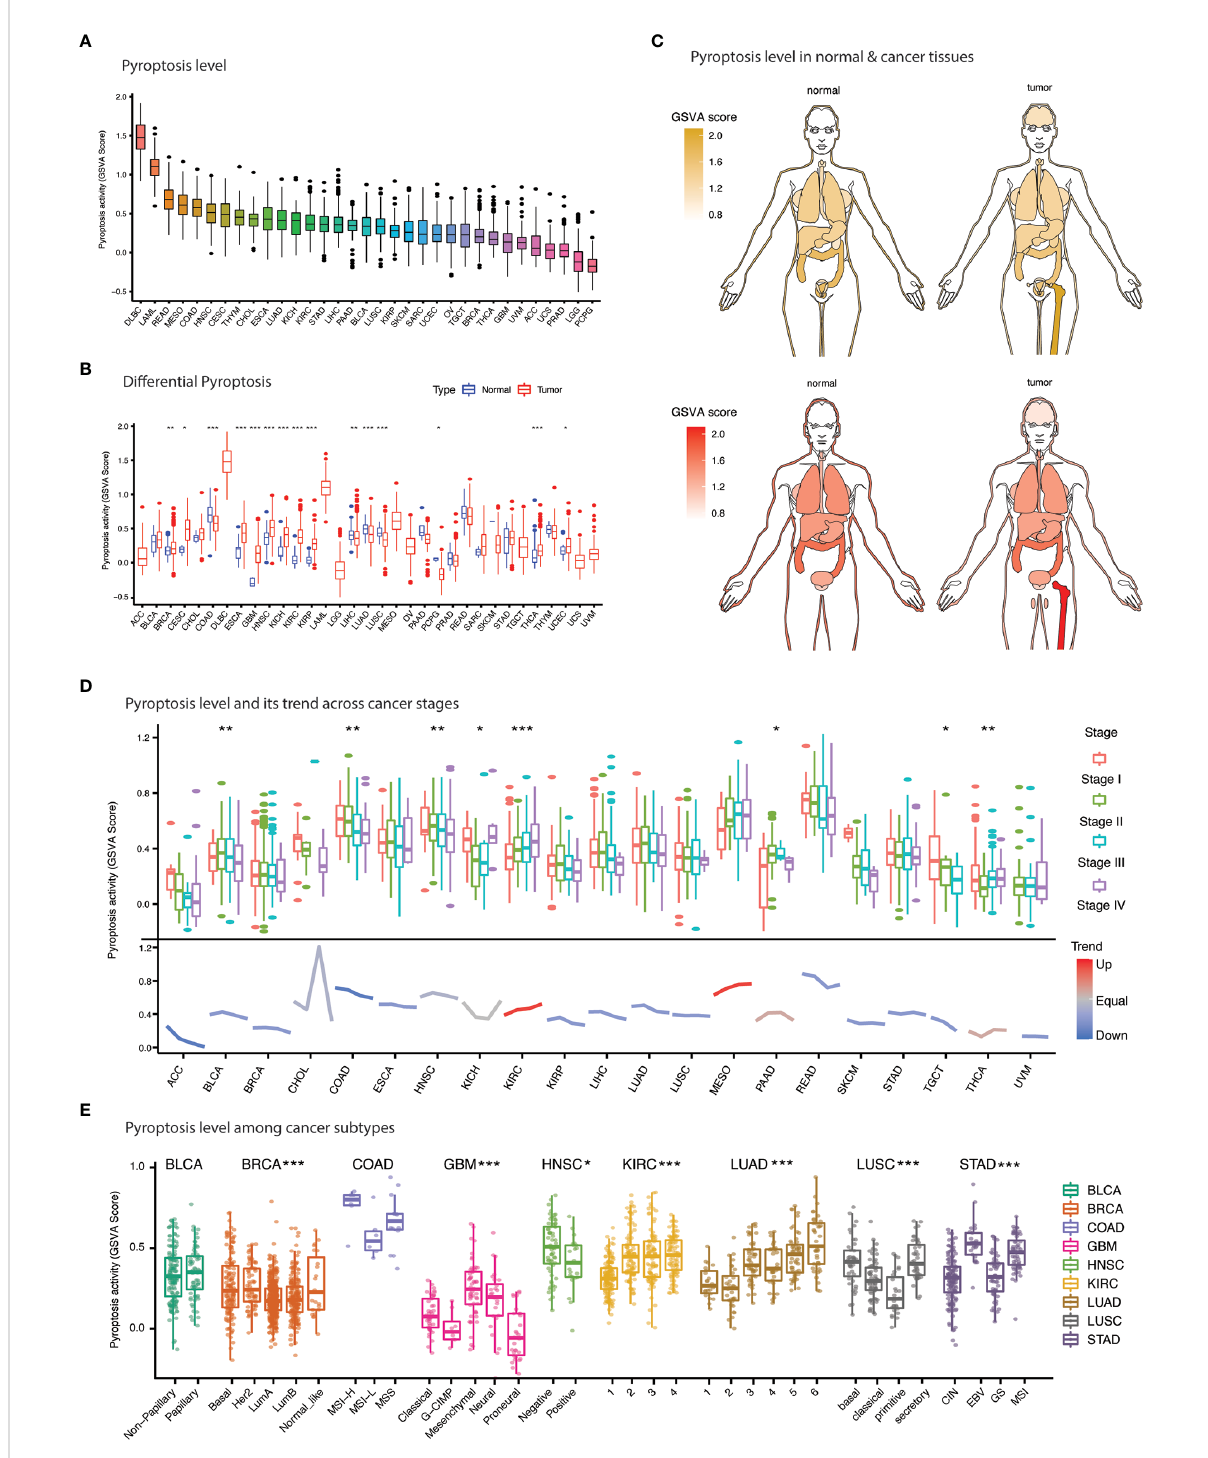
FIGURE 4 Pyroptosis level and clinical features. (A) Anatogram depicting the differential pyroptosis level (GSVA score) between normal (left) and cancer (right) tissues. Yellow and red represent pyroptosis level in female and males. (B) Bar plot illustrates the pyroptosis level (GSVA score) across cancers. (C) Comparison of pyroptosis level (GSVA score) between normal and cancer tissues across 33 cancers. (D) Pyroptosis level and its tendency with cancer stages. (E) Pyroptosis level association with cancer subtypes. * p value < 0.05; ** p value < 0.01; *** p value <